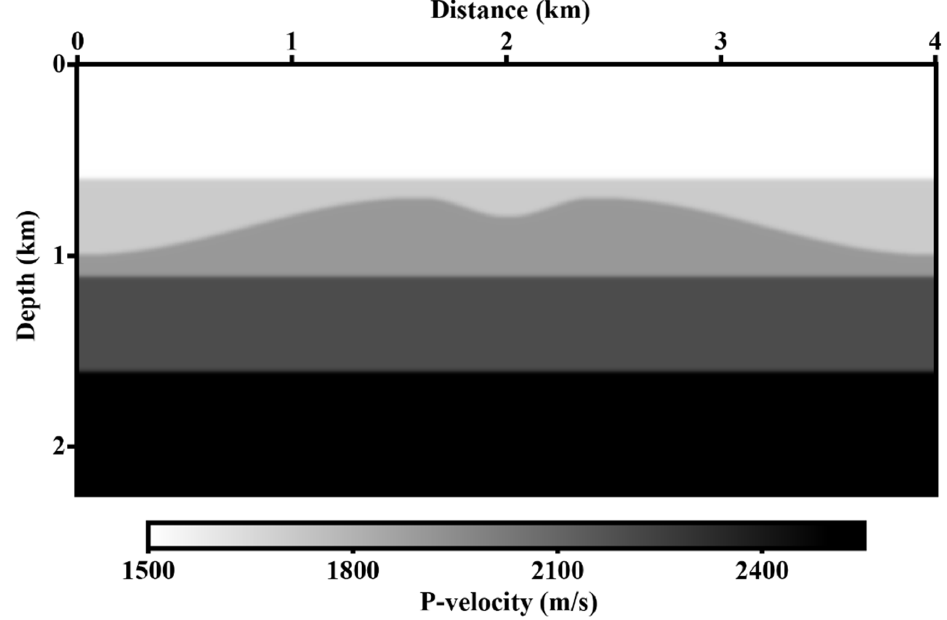
Figure 3. The layered velocity model.